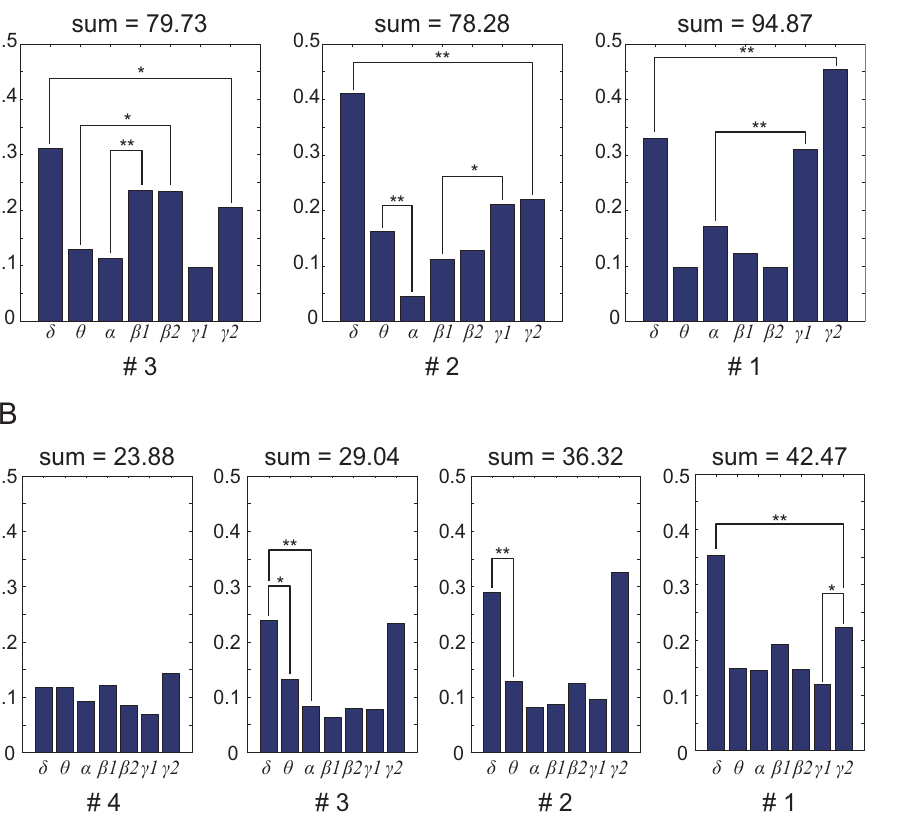
Figure 6. Contribution of each frequency band for EMG prediction. Each panel shows results of multiple comparisons among the frequency bands for each location level (A: monkey A, B: monkey B). Each bar represents the mean of the median weights of each frequency band. At the top of each graph are the sum of the total weights. The # indicates the location of the ECoG electrodes. Noteworthy significant differences between weight values of frequency bands are marked with * ( p , 0.05) and ** ( p , 0.001). Other significance comparisons are omitted for visualization purposes.